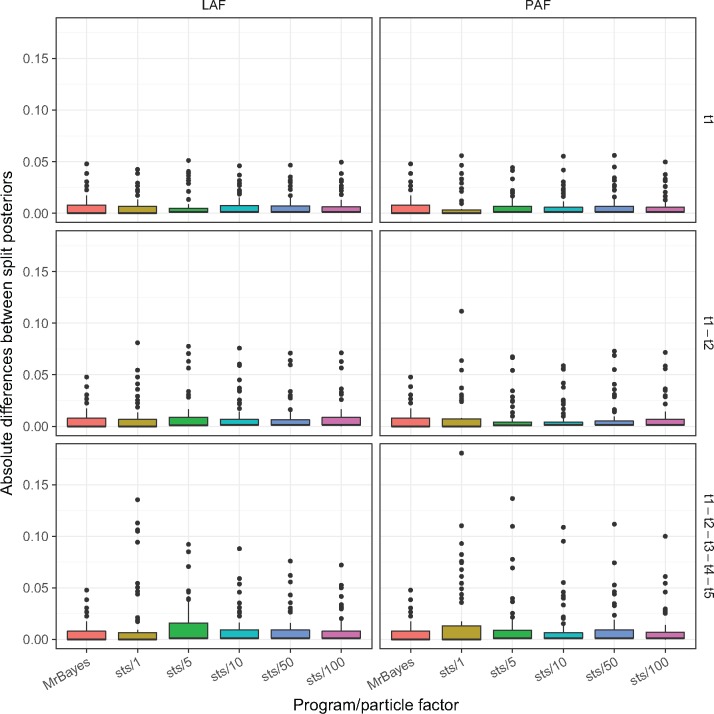
Absolute value of the difference between the split frequencies of \documentclass[12pt]{minimal}
\usepackage{amsmath}
\usepackage{wasysym}
\usepackage{amsfonts}
\usepackage{amssymb}
\usepackage{amsbsy}
\usepackage{upgreek}
\usepackage{mathrsfs}
\setlength{\oddsidemargin}{-69pt}
\begin{document}
}{}$\textsf{sts}$\end{document} and MrBayes. These results are for data set D1T50. Labels on the right of the y-axis indicate which taxa were removed.